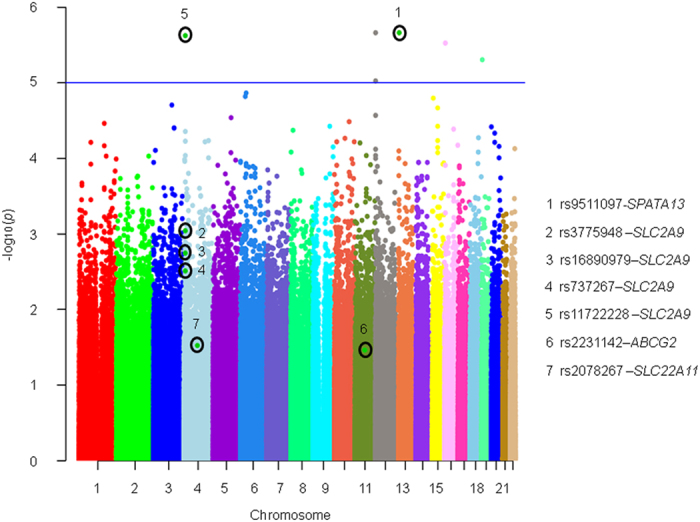
Manhattan plot for the SNPs associated with SUA levels in discovery phase.The -log10 p-values for association of genotyped SNPs are plotted as a function of genomic position (National Center for Biotechnology Information Build 37). The p-values were determined using logistic regression adjusted for age, sex, BMI, PC1 and PC2 in discovery phase analysis. Each chromosome (Chr) has been represented with a unique color.